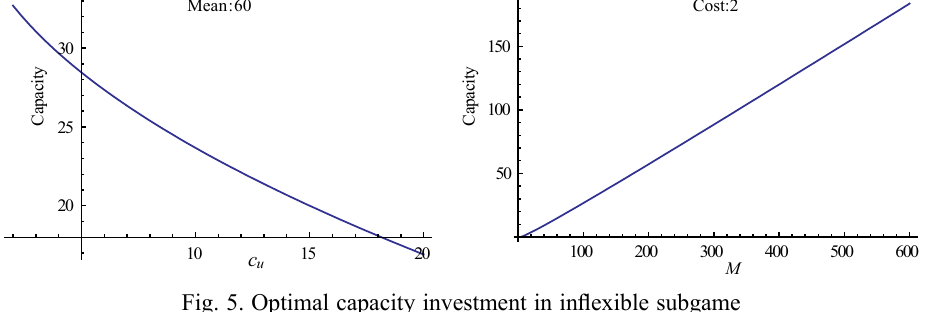
Fig. 5. Optimal capacity investment in inflexible subgame